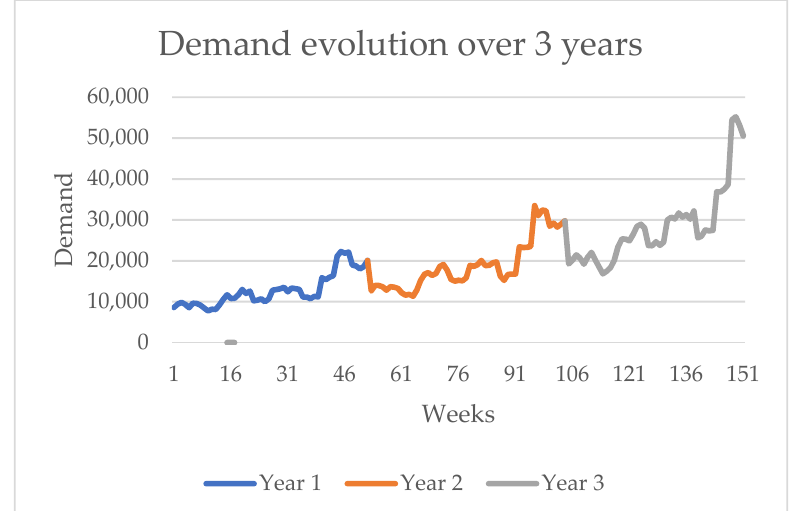
Figure 6. Weekly forecast of the expected demand.